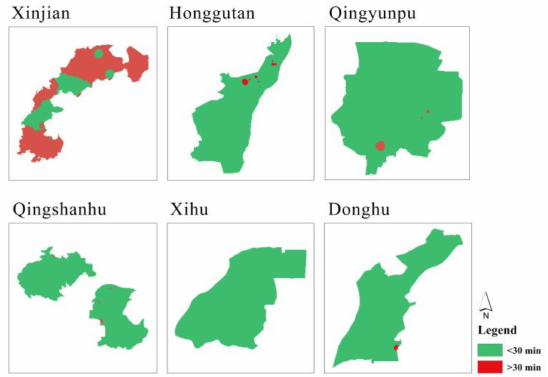
Figure 20. The 30-minute accessibility to outdoor sports venues in each district under the high-risk